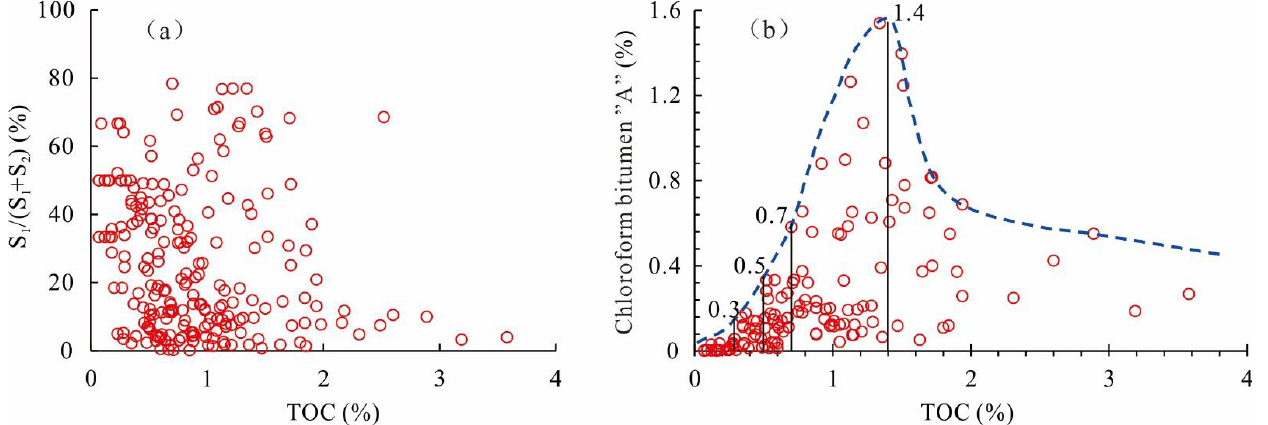
Figure 7. ( a ) Relationship between TOC and productivity index S 1 /(S 1 + S 2 ) of source rocks in the Fengcheng Formation. ( b ) Relationship between TOC and chloroform bitumen “ A ” of source rocks in the Fengcheng Formation.